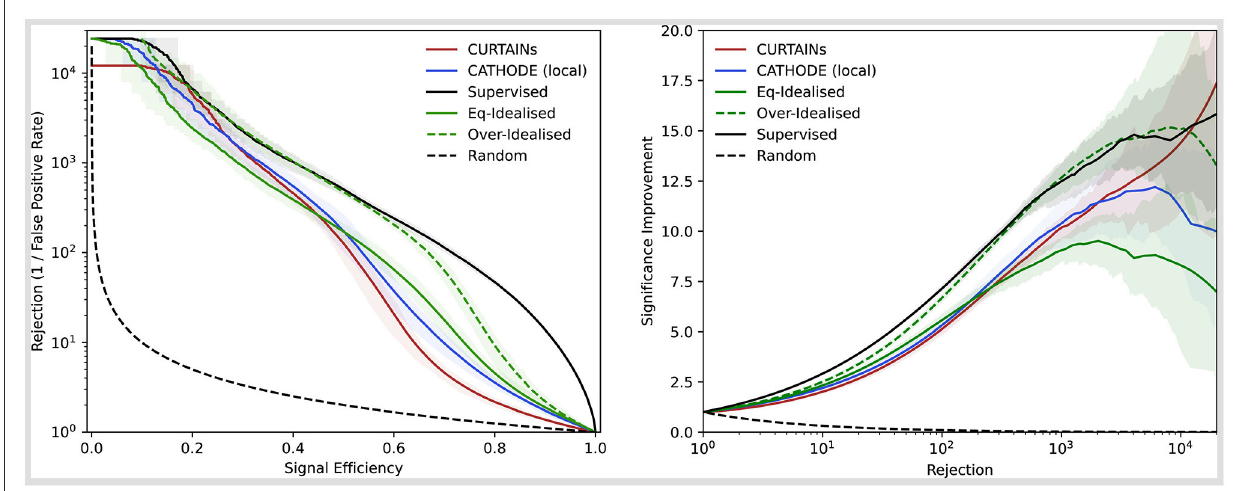
FIGURE6 Background rejection as a function of signal efficiency (left) and signal improvement as a function of background rejection (right) for the different background template models (C URTAIN s—red, C ATHODE —blue, Eq-Idealised—green, Over-Idealised—dashed green) and a fully supervised classifier (black). The sample with 3,000 injected signal events in used to train all classifiers in the signal region 3,300 the mean value of fifty classifier trainings with different random seeds. The uncertainty encompasses 68% of the runs either side of the mean.